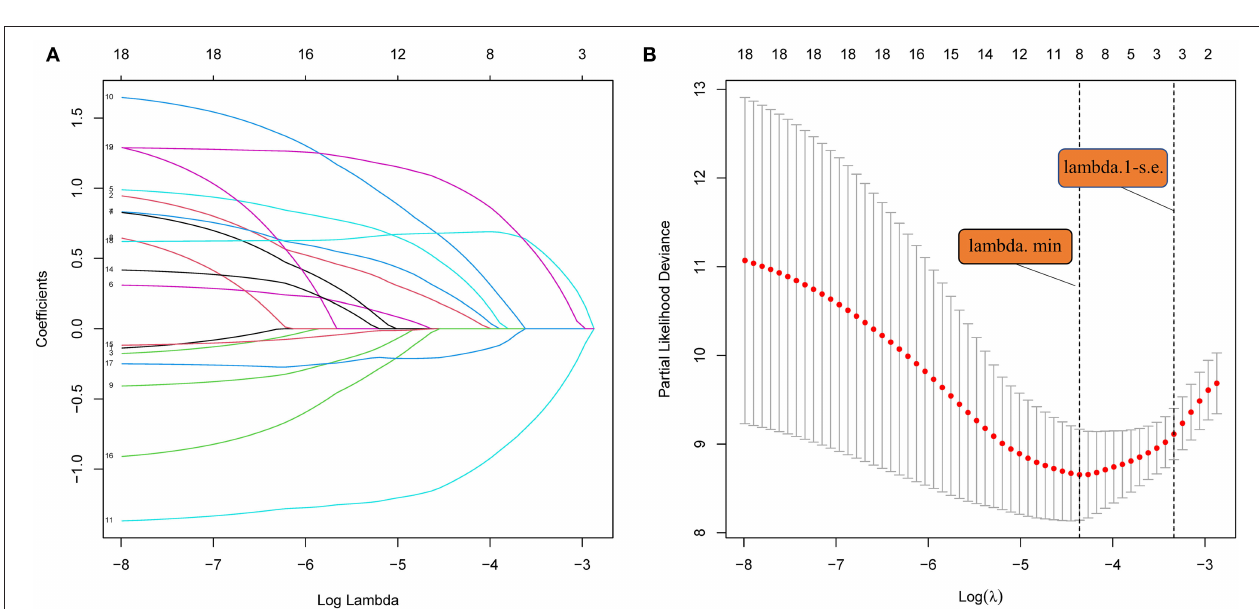
FIGURE 2 | Receiver operating characteristic curve of the nomogram 1 and nomogram 2 in the training set. (A) The red line represents 2-year recurrence-free in nomogram 1. The green line represents 5-year recurrence-free rate in nomogram 1. (B) The red line represents 2-year recurrence-free rate in nomogram 2. The green line represents 5-year recurrence-free rate in nomogram 2.